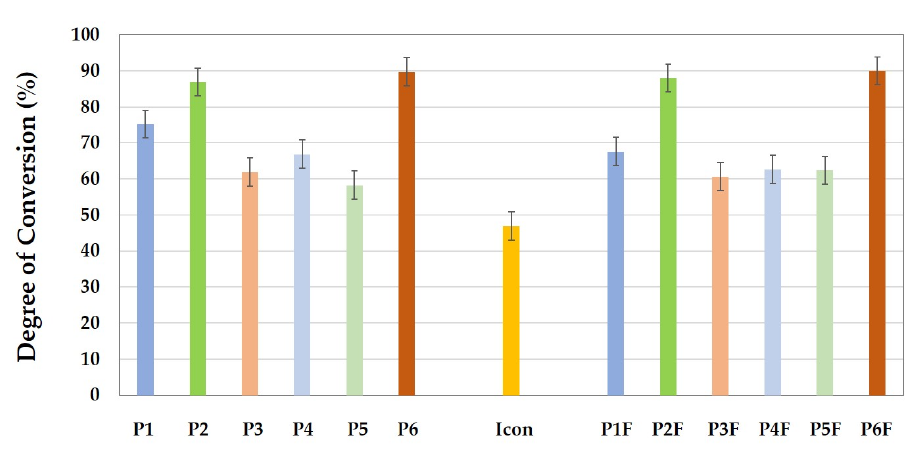
Figure 1. Graphical representation of the degree of conversion for the experimental infiltrants with and without filler in the composition, compared to the commercial Icon infiltrant, 24 h after polymerization.